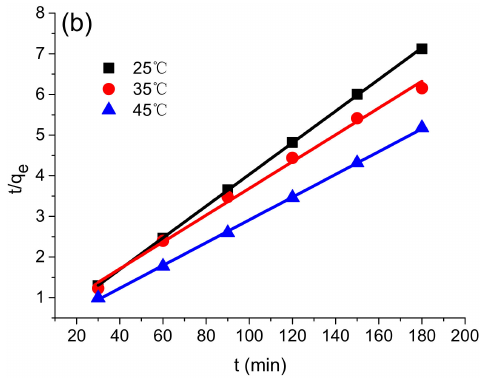
Figure 7. Fitting with the pseudo-first-order model ( a ) and the pseudo-second-order model ( b